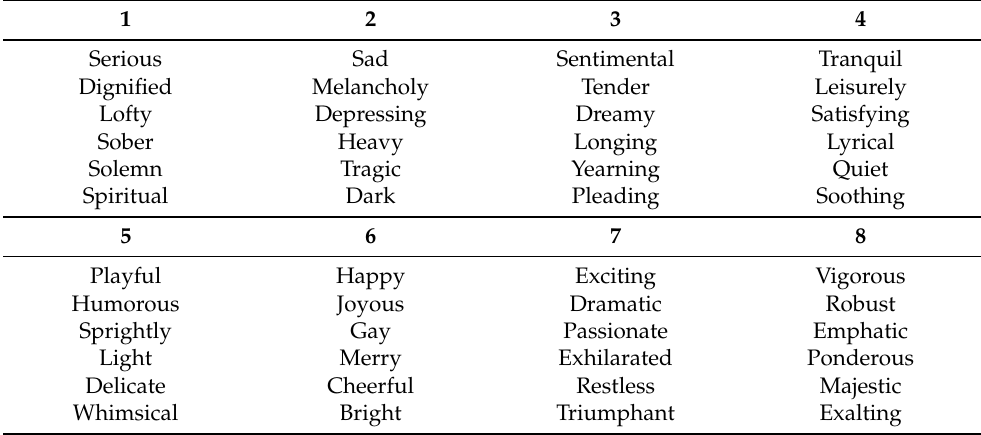
Table 2. The eight adjective groups presented to participants in Experiment 2, taken from Hevner’s adjective